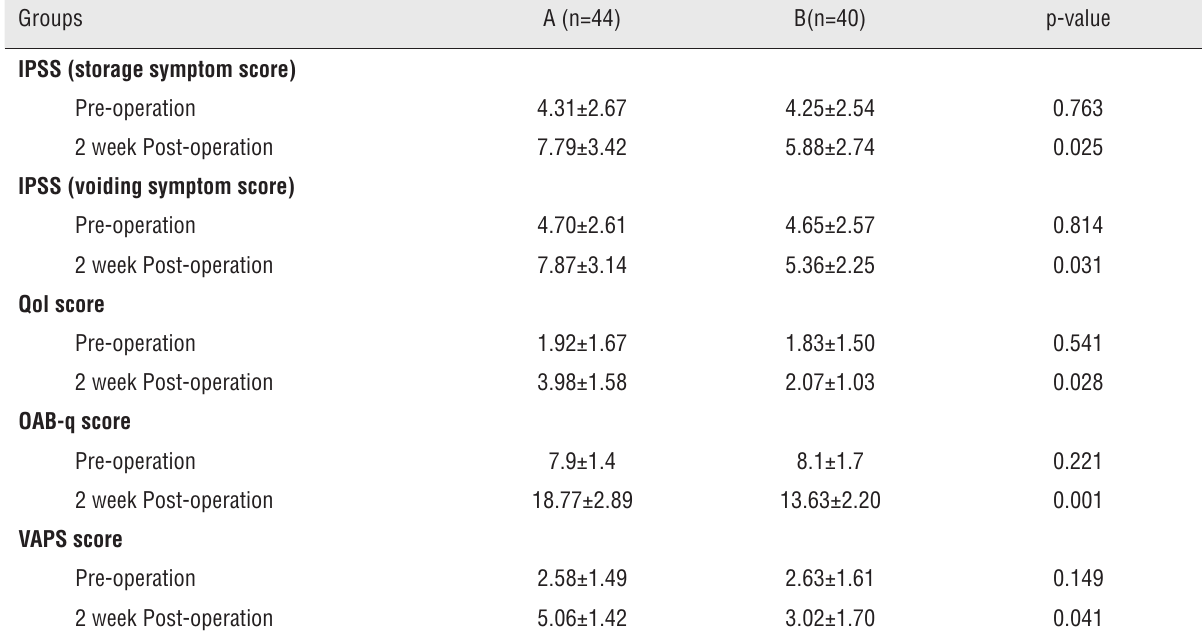
Table-4 - Comparisons of IPss/qol, VaP scale, and Oab-q scores. Groups A